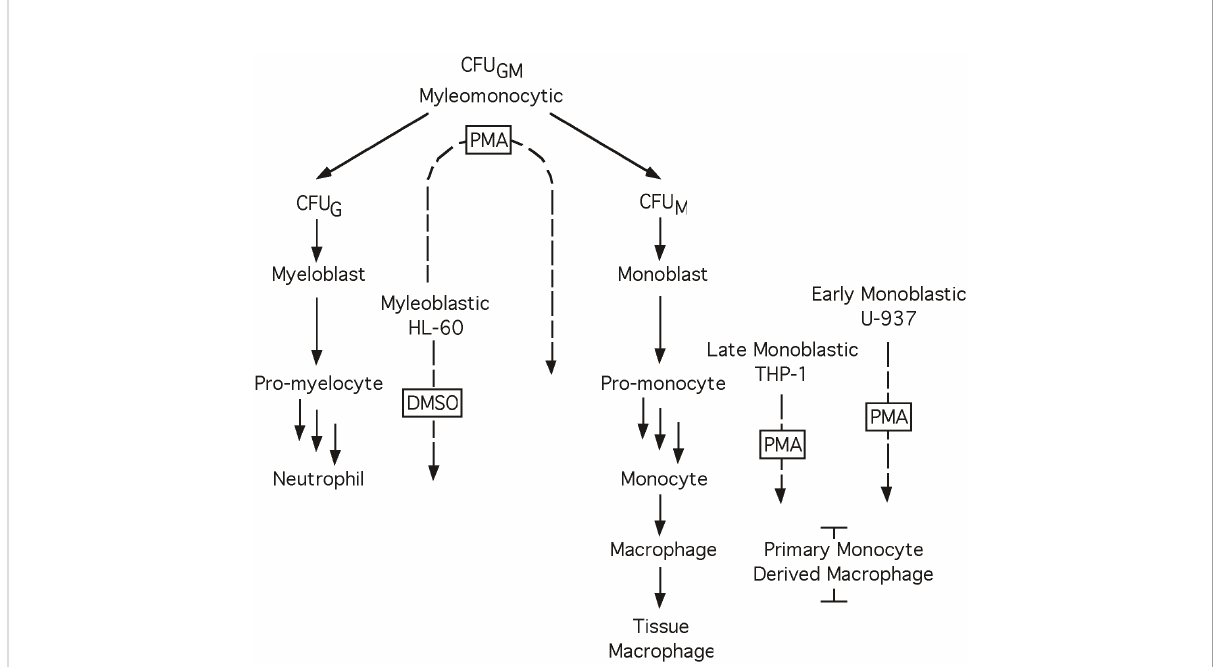
FIGURE 1 Myeloid differentiation. Diagrammatic representation of the process of myeloid differentiation. Cell lines and primary cell preparations are shown at their approximate stage in the differentiation process, dotted arrows indicate a cell line ’ s ability to differentiate towards a given cell type in the presence of the boxed chemical inducer. When treated with PMA cell lines HL-60 (48 hrs), THP-1 and U-937 (24 hrs) differentiate toward the monocyte lineage. When treated with DMSO cell line HL-60 (48 hrs) differentiates toward the granulocyte